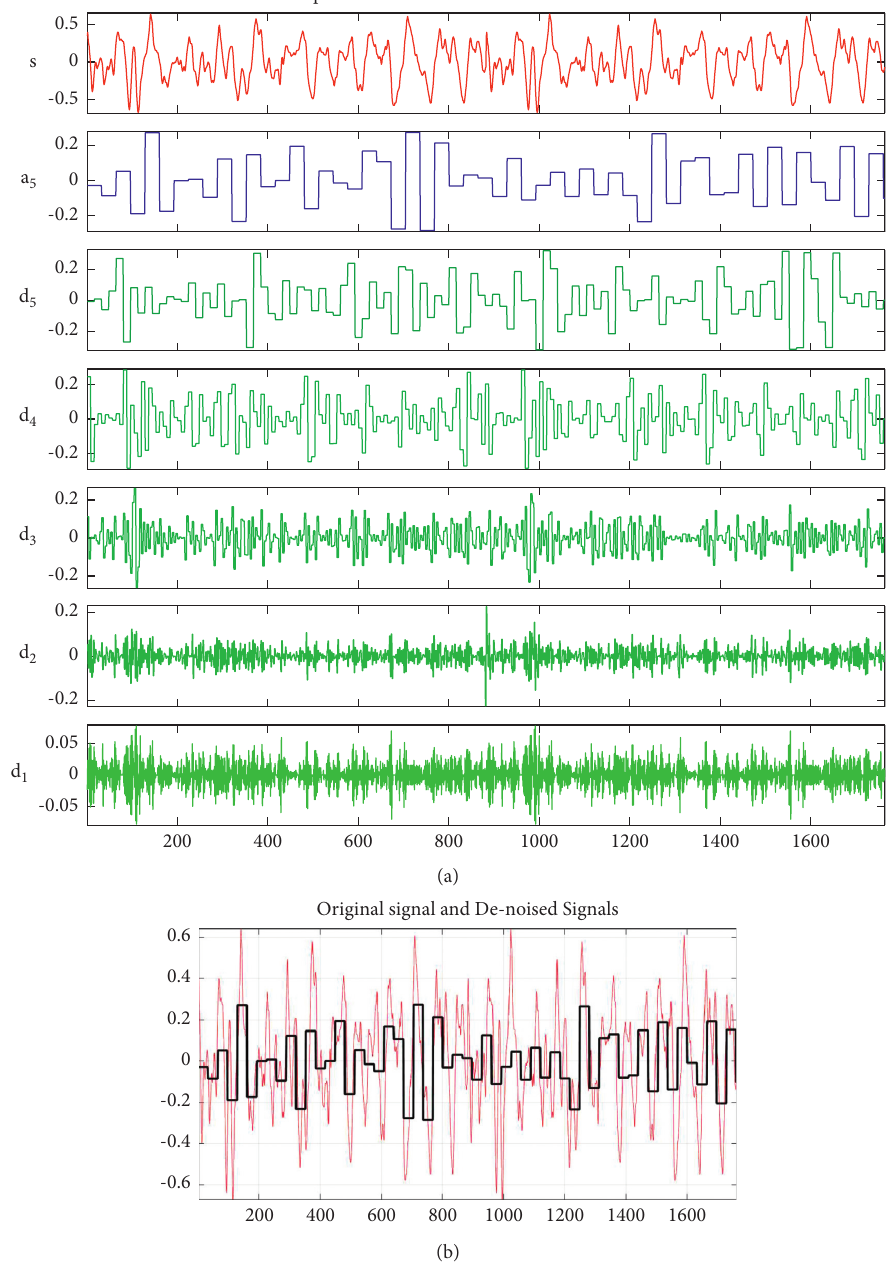
Figure 3: (a) Original signal decomposition diagram. (b) Comparison of original signal and denoised Figure 6(a) simulates the sound of the fan under load. Simulate five groups of audio signals in this state, namely, G 1, G 2, G 3, G 4, and G 5, and calculate the proportion of each